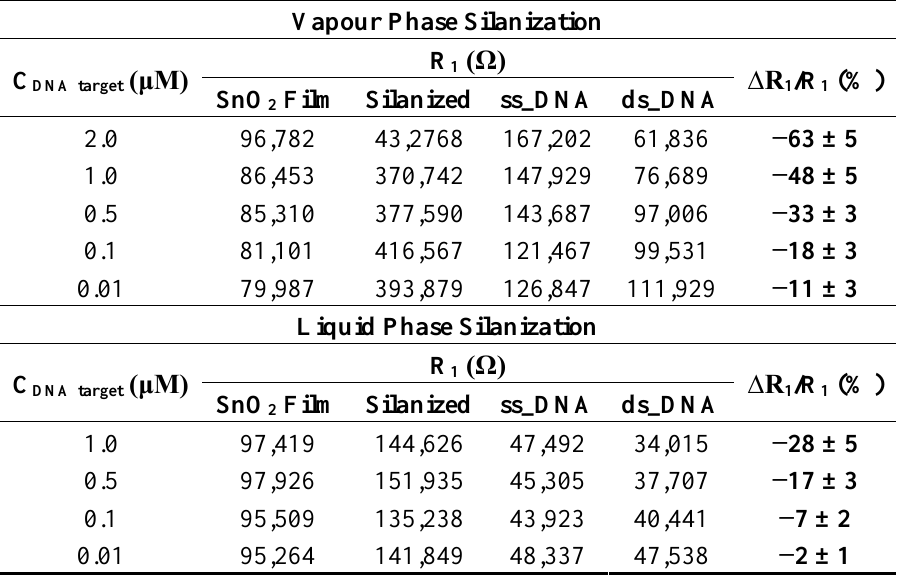
Table 4. Vapour phase and liquid phase silanization: resistance value R 1 obtained from fitting experimental data to the equivalent circuit for 220-nm-thick-nanoporous-SnO 2 electrodes after silanization, after DNA probe immobilization and after complementary DNA hybridization with different target concentrations.